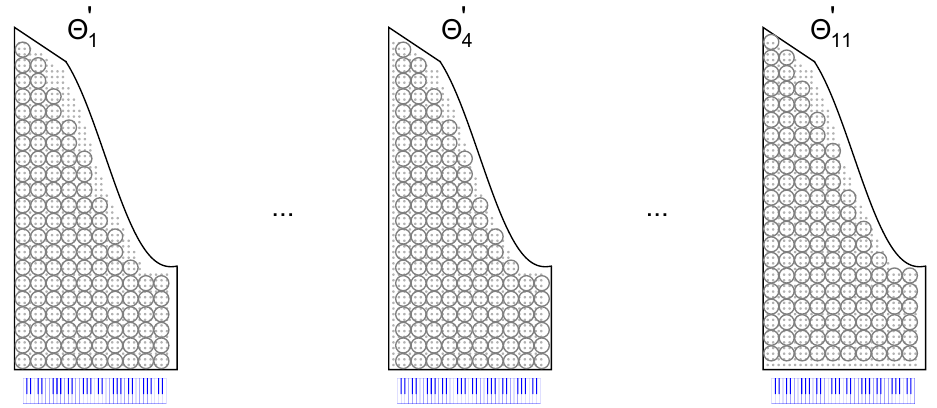
Figure 10. Three regular loudspeaker grids Θ (cid:48) 128 loudspeakers. In the given setup W = 11 loudspeaker grids are